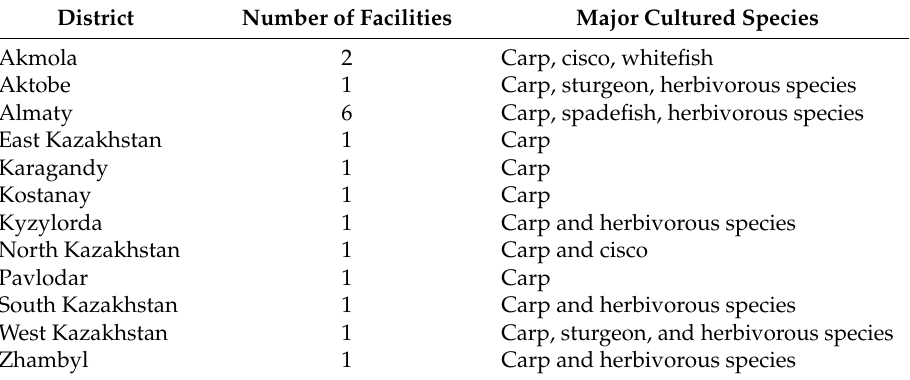
Table 2. Location and specialization of Kazakhstan’s aquaculture facilities as of 1994. The information is based on data available in